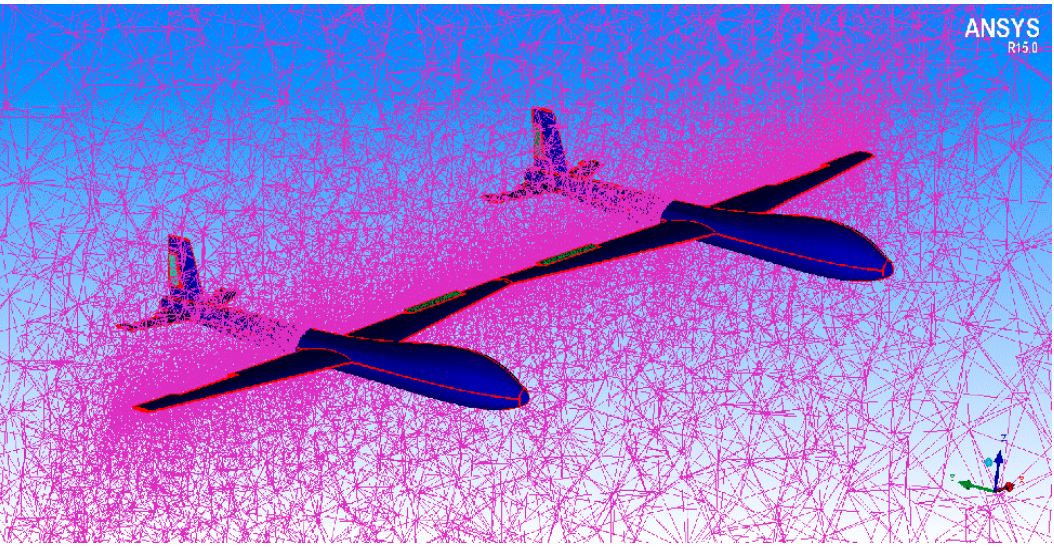
Figure 6. Wingtip-jointed aircraft system unstructured grid.